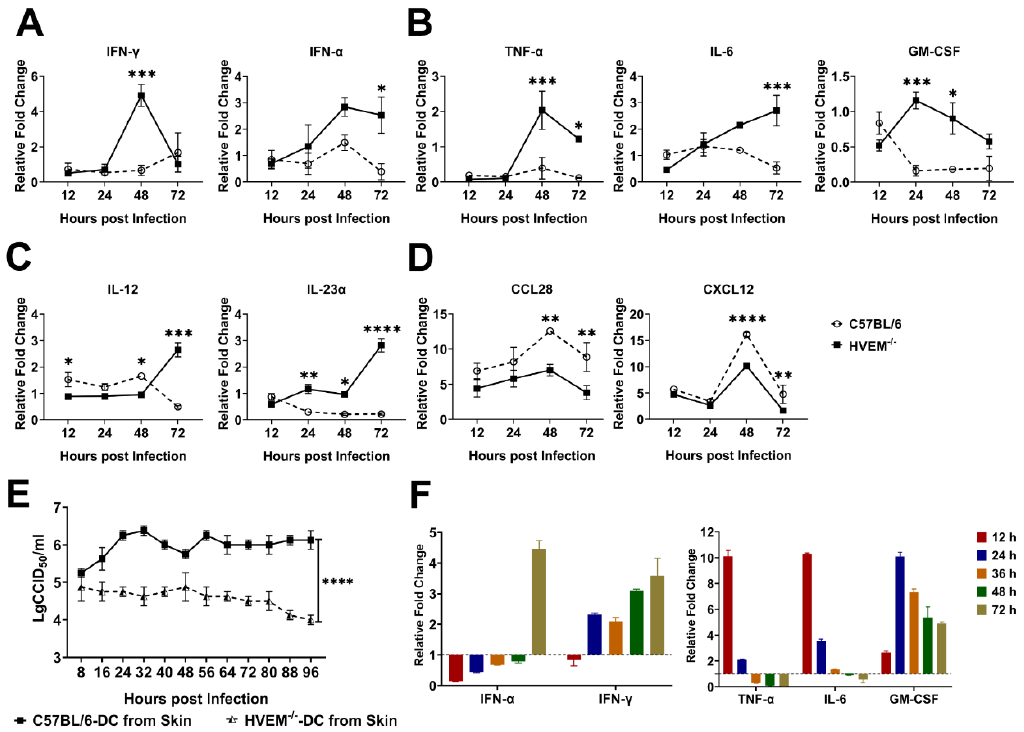
Figure 3. Change in the inflammatory response and the transcriptional expression of immune signaling molecules. ( A ) IFN- α , IFN- γ , ( B ) TNF α , IL-6, GM-CSF, ( C ) IL-12, IL-23 α , ( D ) CCL12 and CXCL28 expression in the skin of C57BL/6 and HVEM − / − mice after infection with HSV-1 was measured ( n = 3 per timepoint in each group). ( E ) Analysis of the viral titer in dendritic cells from the skin and bone marrow of C57BL/6 and HVEM −/− mice infected with HSV-1 and cultured in vitro for different times ( n = 3 per timepoint in each group). ( F ) IFN- α, IFN - γ, TNFα, IL -6, and GM-CSF levels in mouse HSV-1-infected dendritic cells from the skin of C57BL/6 mice cultured in vitro. The gene expression of HSV-1-infected dendritic cells from C57BL/6 mice is shown as the fold-change (2 −∆∆Ct ) relative to the levels in samples from un-infected dendritic cells of C57BL/6 mice, which were used for calibration ( n = 3 per time point in each group). Statistical significance was assessed by two-way ANOVA with Holm – Sidak adjustment for multiple comparisons (*, p < 0.05; **, p < 0.01; ***, p < 0.001; ****, p < 0.0001).